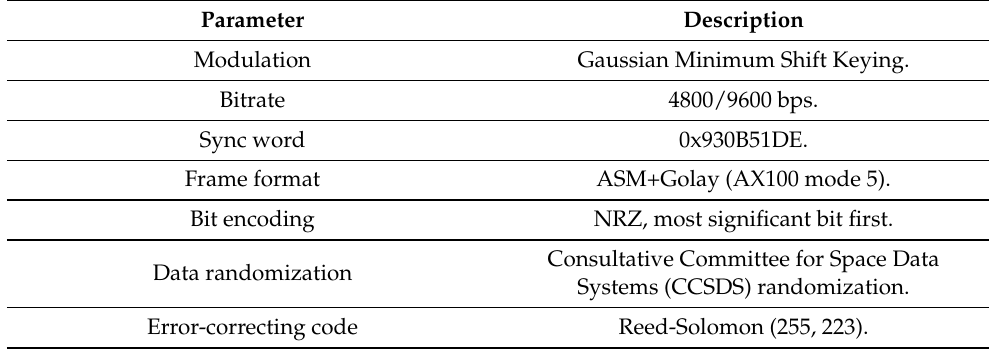
Table 3. AlfaCrux data link